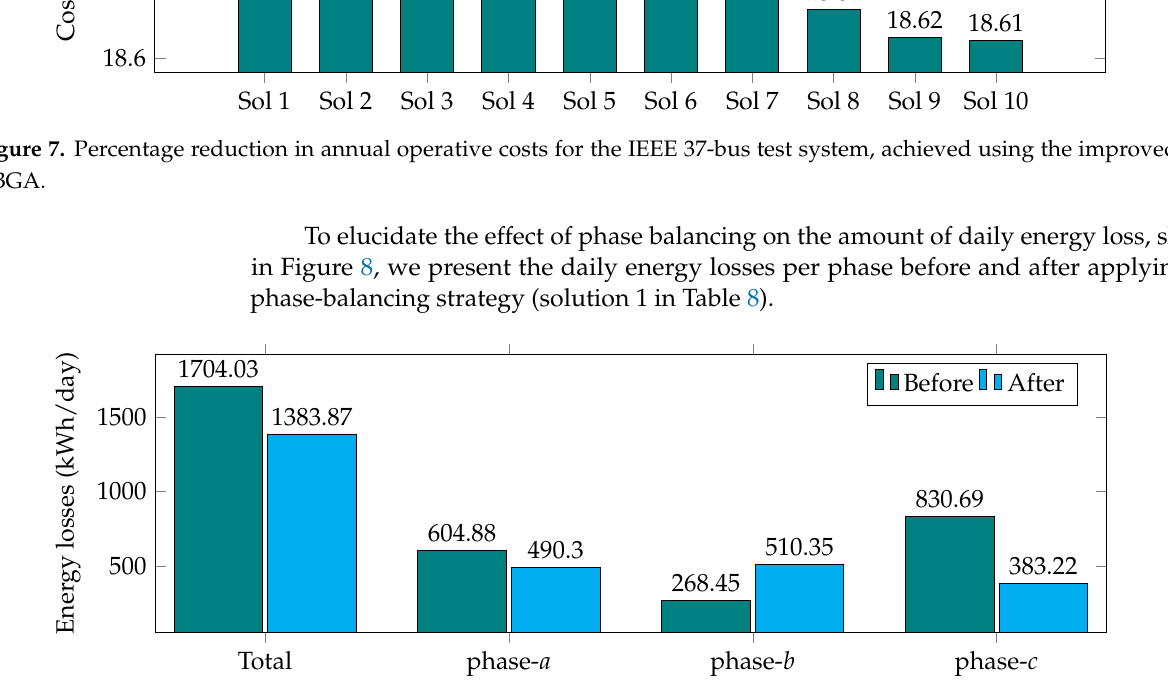
Figure 8. Effect of phase balancing on the amount of power losses in the IEEE 37-bus test feeder. The results presented in Figure 8 indicate the following: (i) the benchmark case shows that the difference in the daily energy losses between phases b and c is approximately 562.2398 kWh/day, which confirms the higher imbalance in the IEEE 37-bus system; (ii) after applying the phase-balancing strategy, the difference between phases b and c is just 127.1357 kWh/day, which represents a reduction of 77.3876% with respect to the benchmark case; and (iii) the phase-balancing approach leads to better load distribution per phase, which balances the power losses among them with differences lower than 130 kWh/day in the worst